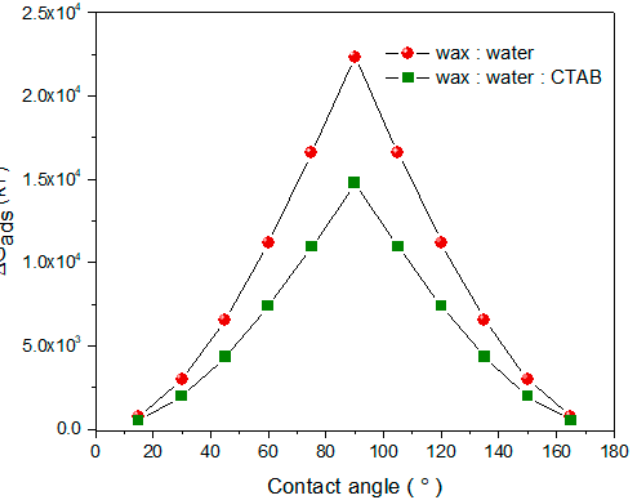
Figure 4. Adsorption energy ( ∆ G ads ) of BHF NPL at the wax-water interface, (with and without surfactant CTAB) for various contact angles between the wax and water.